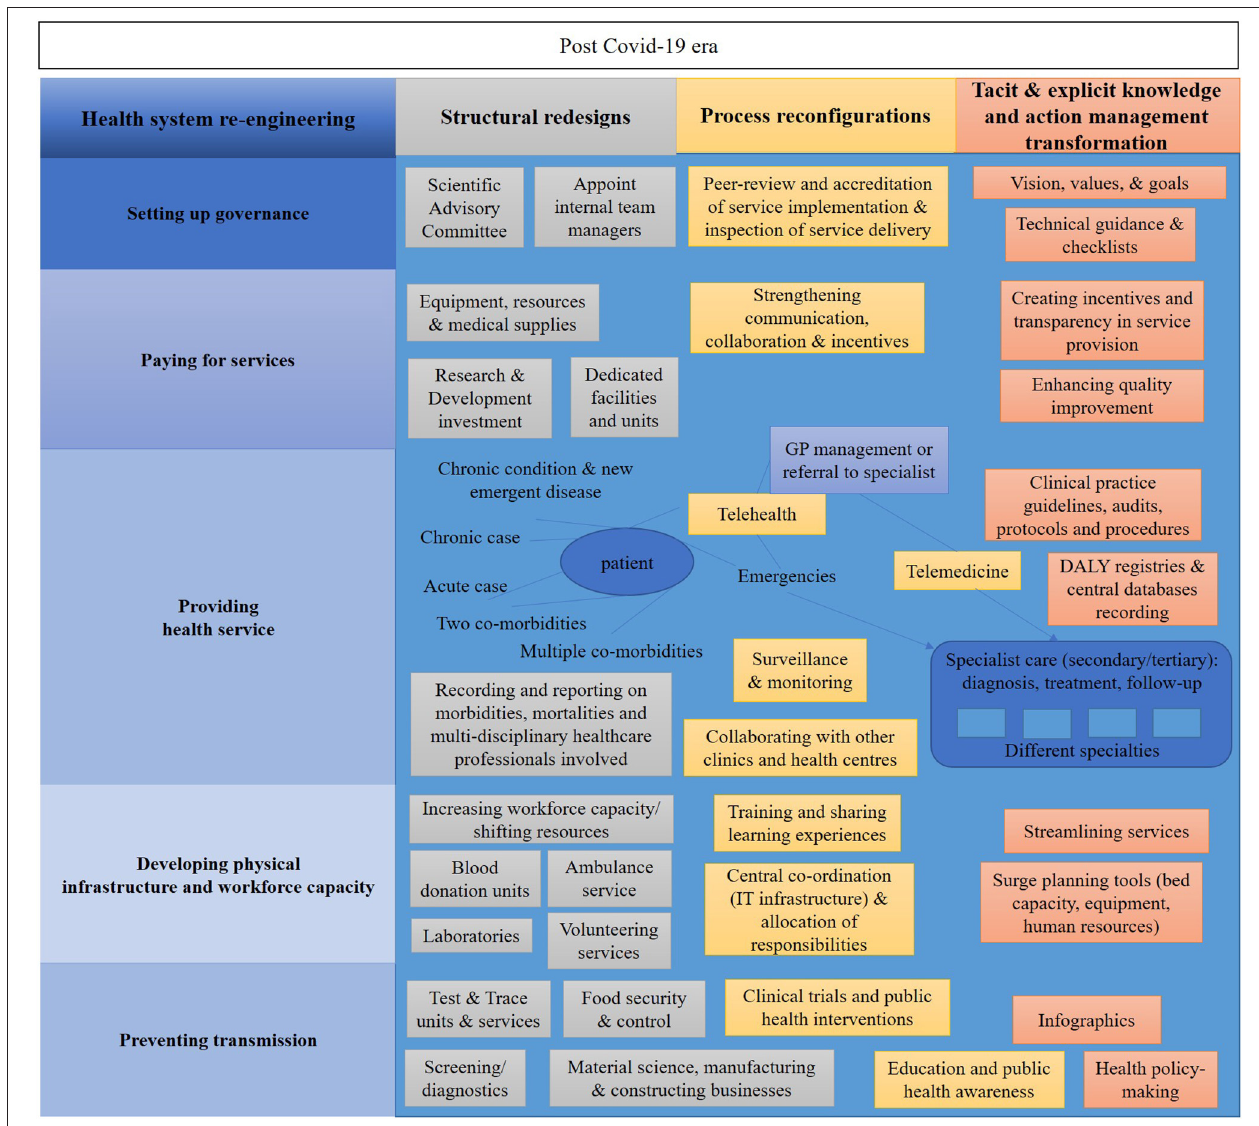
FIGURE 4 | The proposed re-engineering health system set-up and organization in the post COVID-19 era.